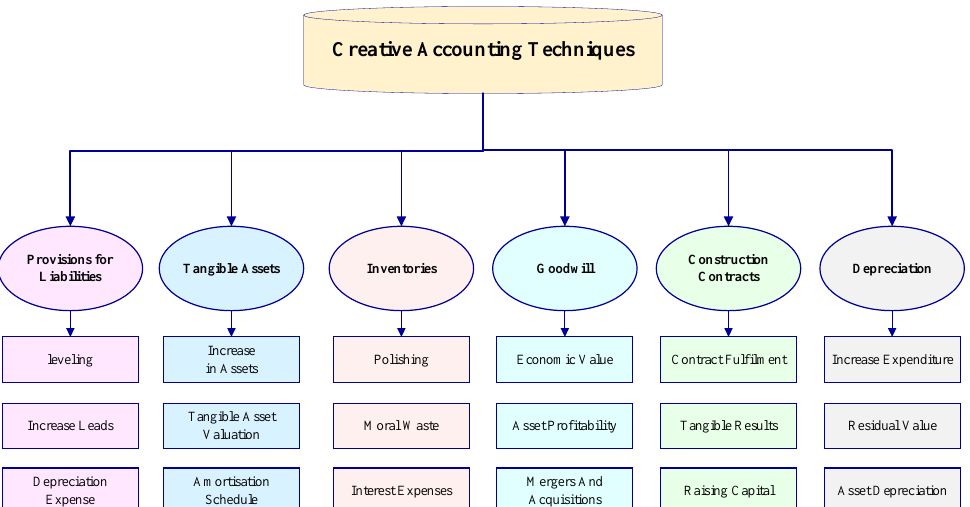
Figure 3. Creative accounting techniques. Source: Own elaboration.